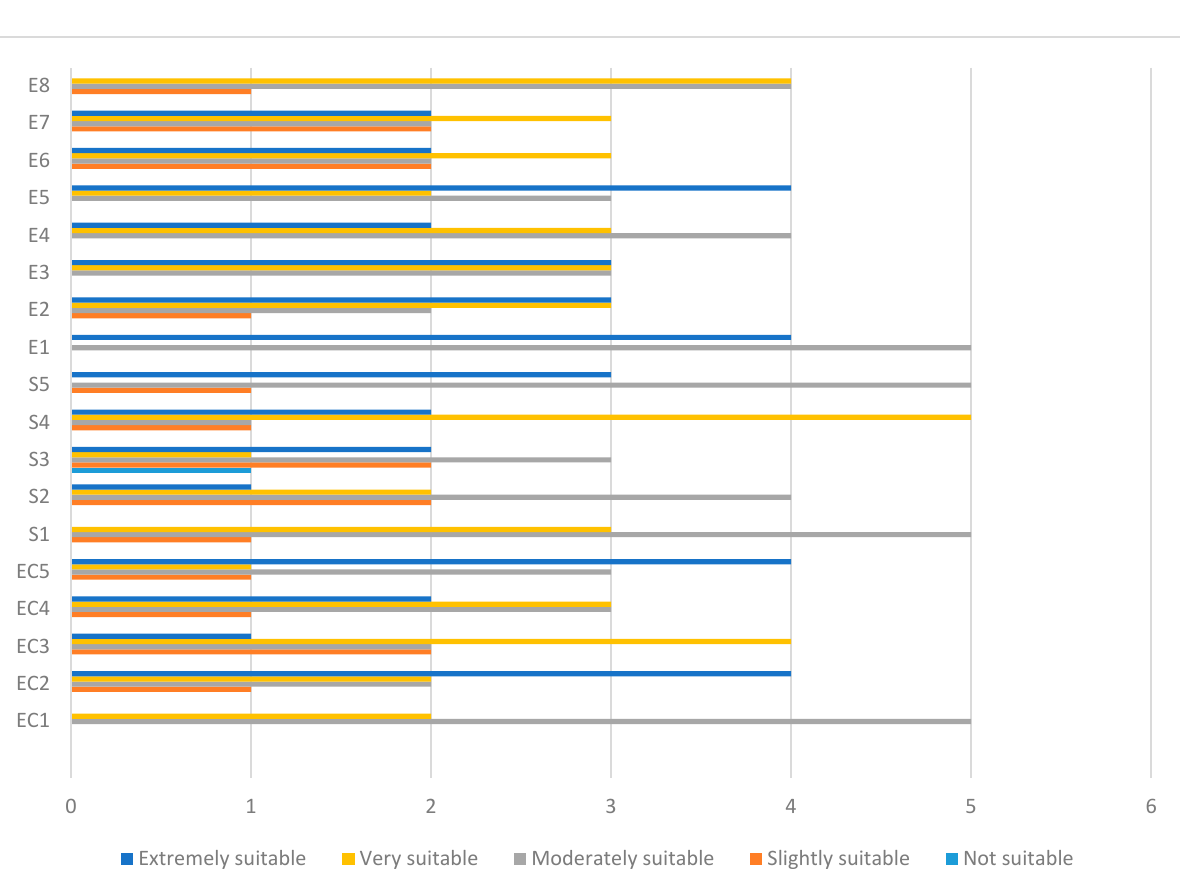
Figure 7. Key performance indicators to assess the sustainability of SC4.0.